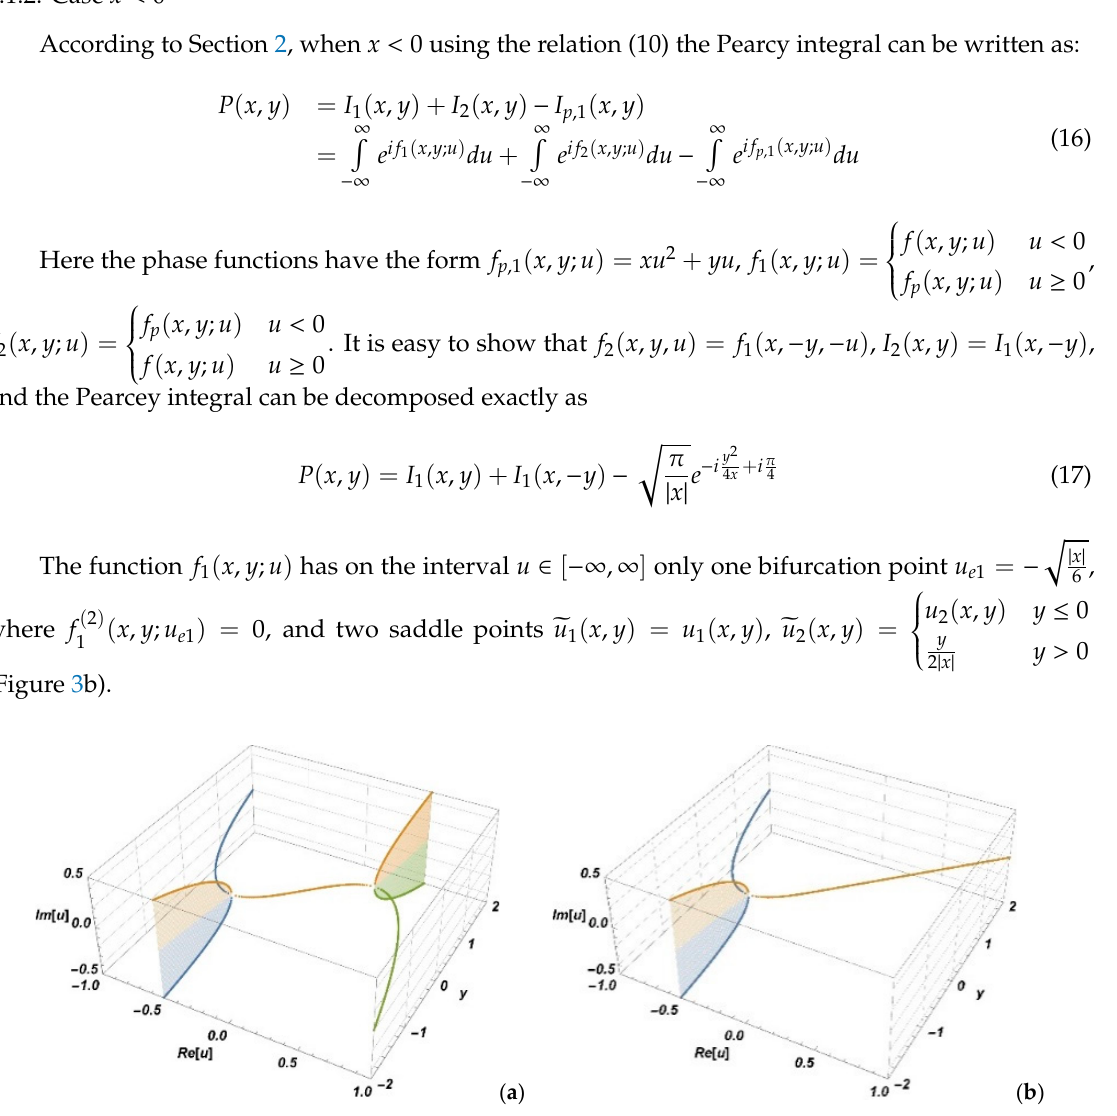
u , u , and u ) of the functions (1) (1, ; ) f y u and (1) ( 1, ; ) f y u − are shown in 1 2 3